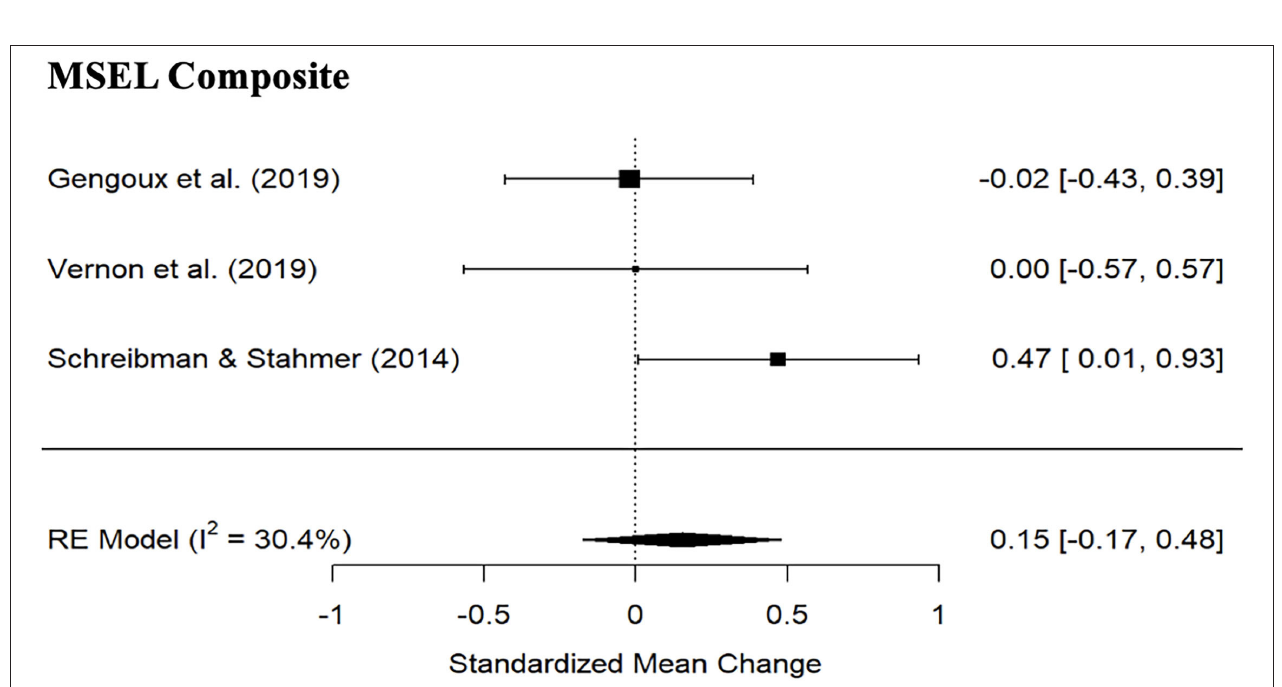
FIGURE 5 | Forest plot of estimates for PRT effects for Mullen Scales of Early Learning composite